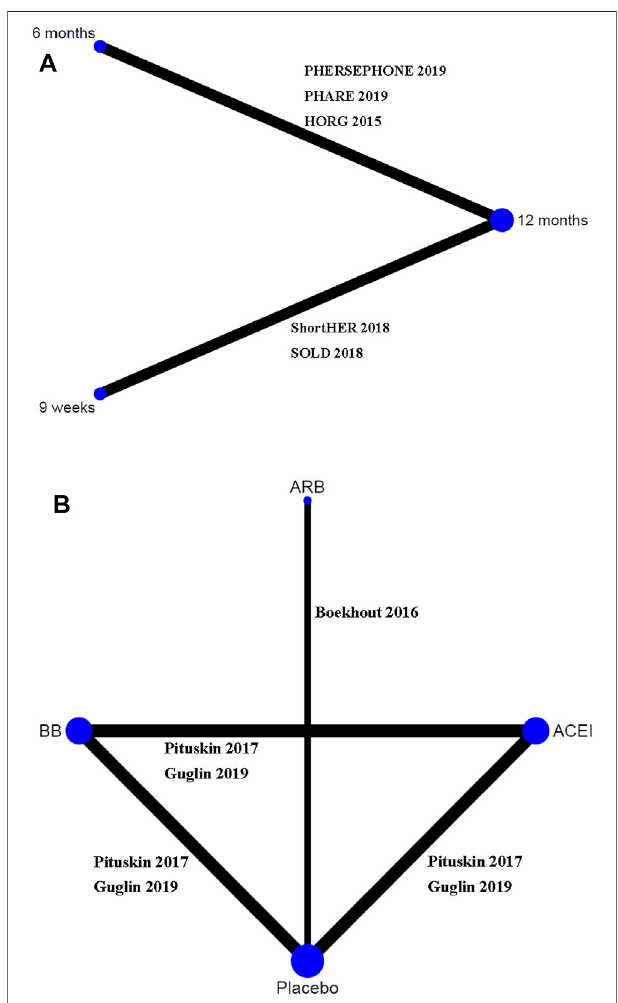
FIGURE 2 | Network evidence plots of interventions for preventing cardiotoxicity in breast cancer patients receiving trastuzumab. (A) Short duration of trastuzumab using cardiotoxicity as the outcome; (B) cardioprotective drug intervention.